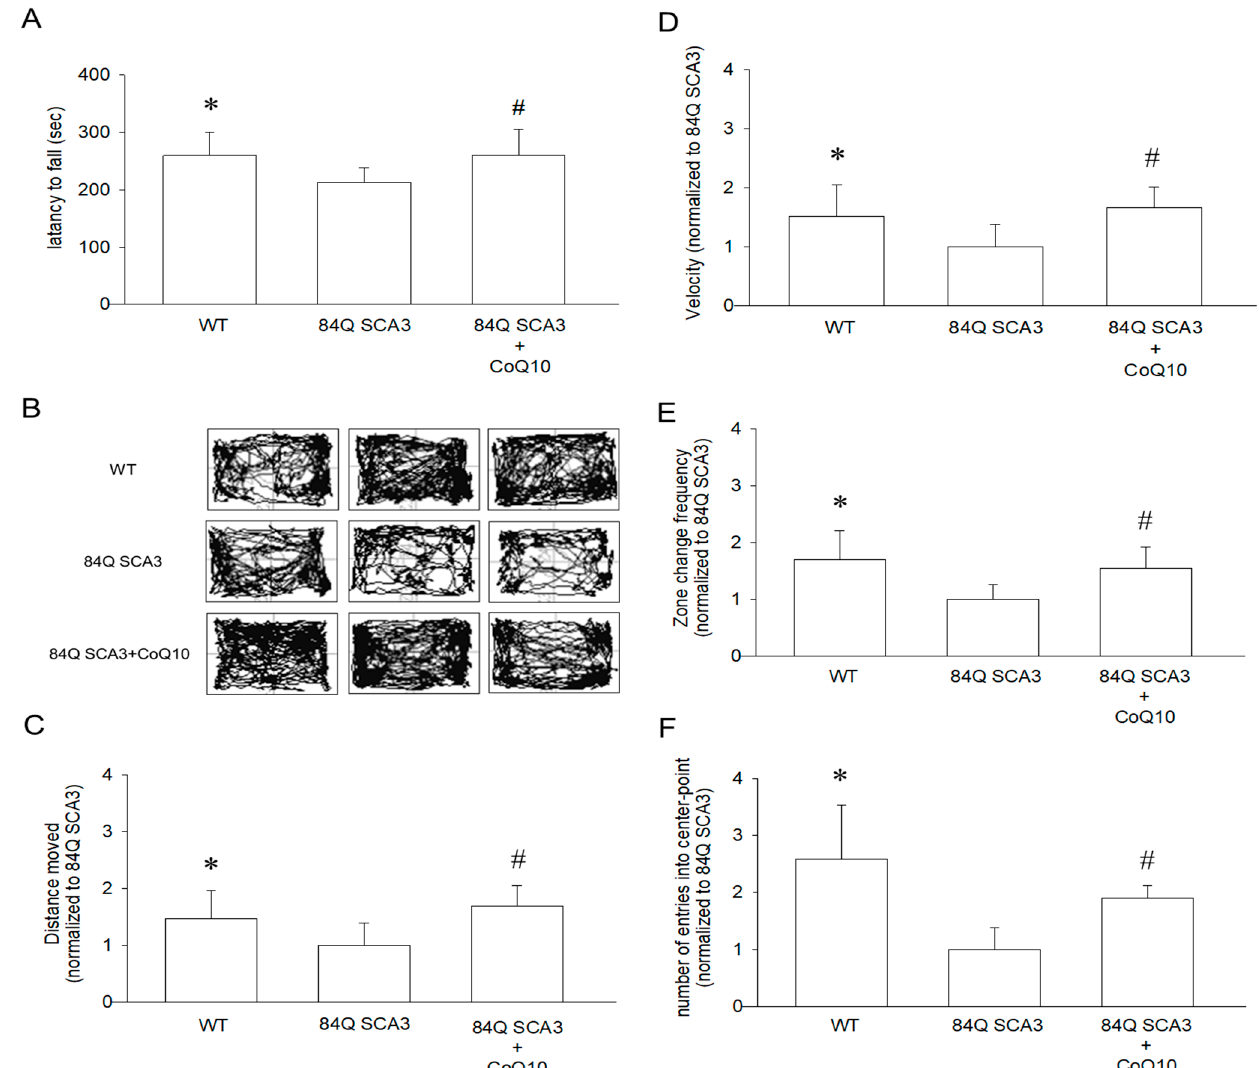
Figure 2. Effects of CoQ10 on rotarod performance and open-field behavior in 84Q SCA3 mice.